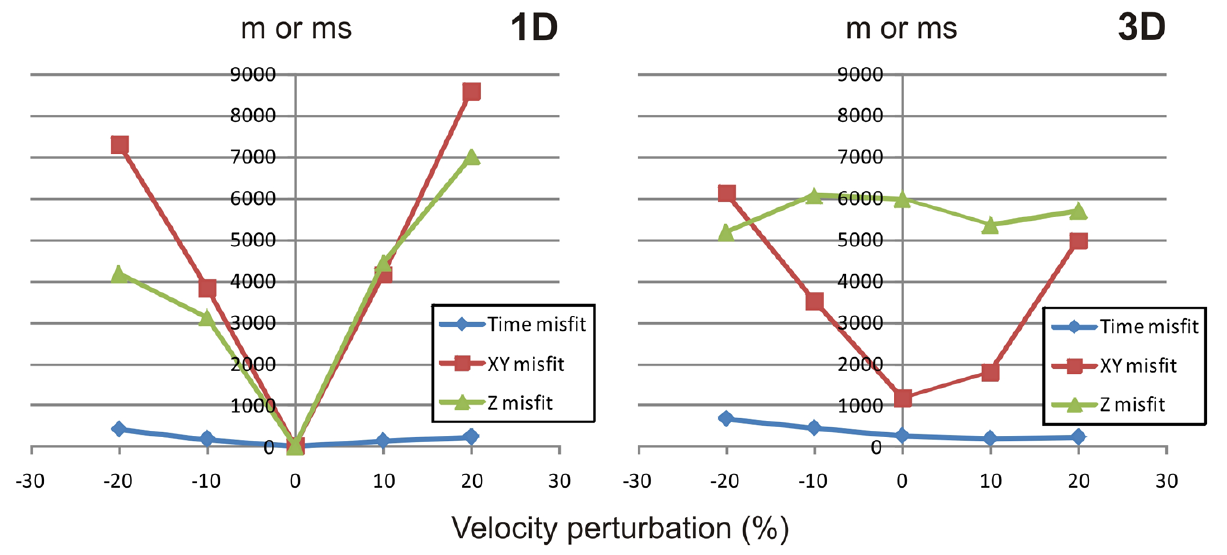
Figure 6. Time and hypocentral misfits for a 1D model (left) and a 3D model (right). The vertical axis indicates meters for the misfits in space (green and red lines), and milliseconds for the misfit in time (blue line).